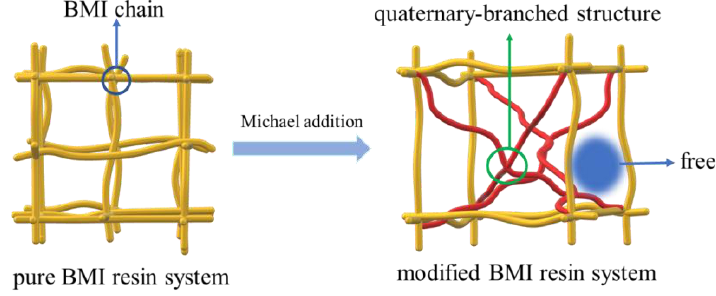
Figure 1. Cured network structure of modified